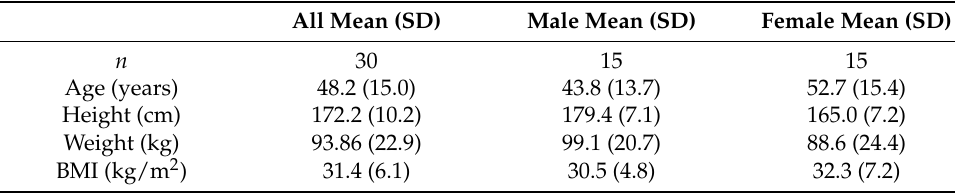
Table 1. Baseline Characteristics of the Study Subjects ( n = 30).